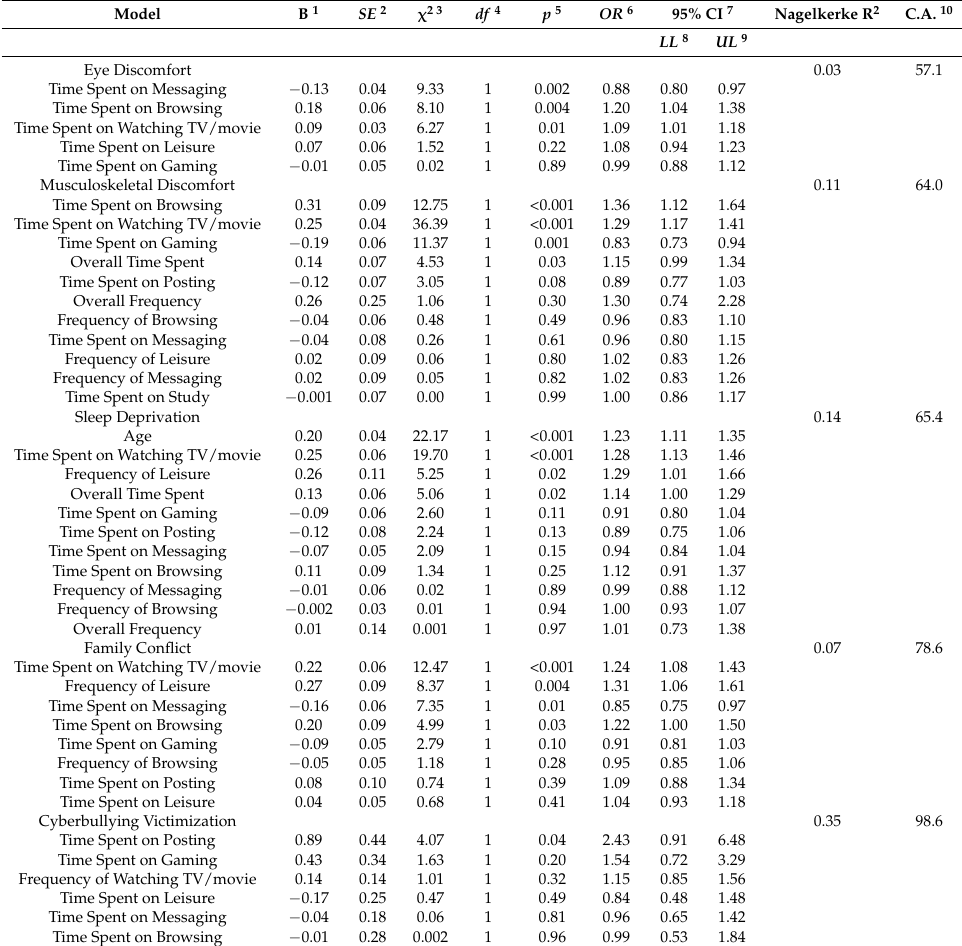
Table 8. Complex sample binary logistic regression estimating likelihood of perceived outcomes among secondary school